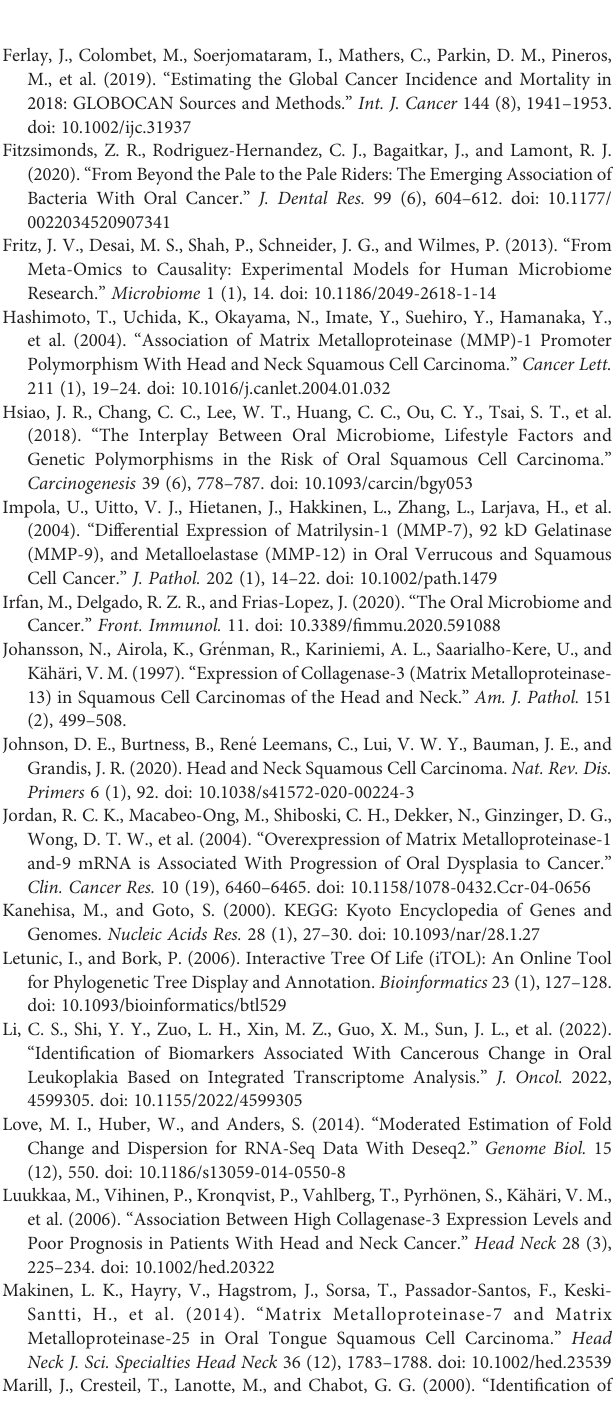
Supplementary Table 5 | The homolog searched results of CYP3A4 genes. Supplementary Table 6 | The homolog searched results of MMP13 genes. Supplementary Table 7 | The homolog searched results of MMP7 genes. Supplementary Table 8 | The homolog searched results of MMP1